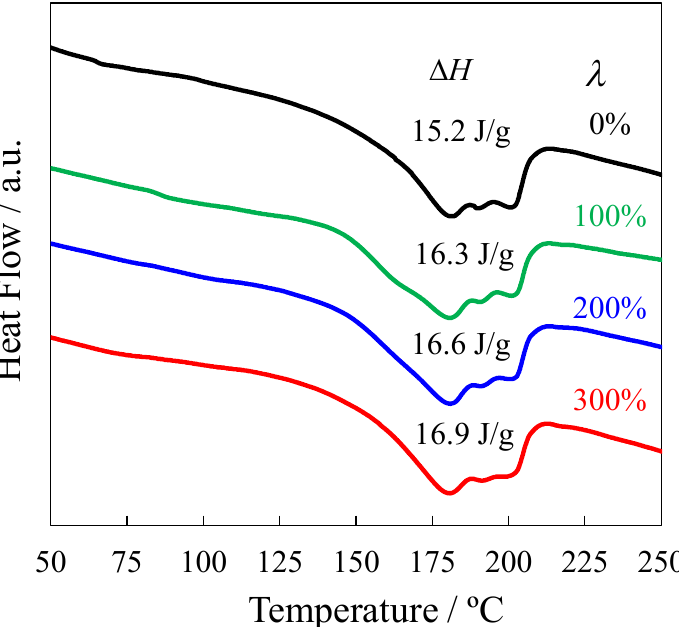
Figure 4. DSC curves for the melting peak of heat-elongated TPU films obtained at various elonga- tion ratios λ .